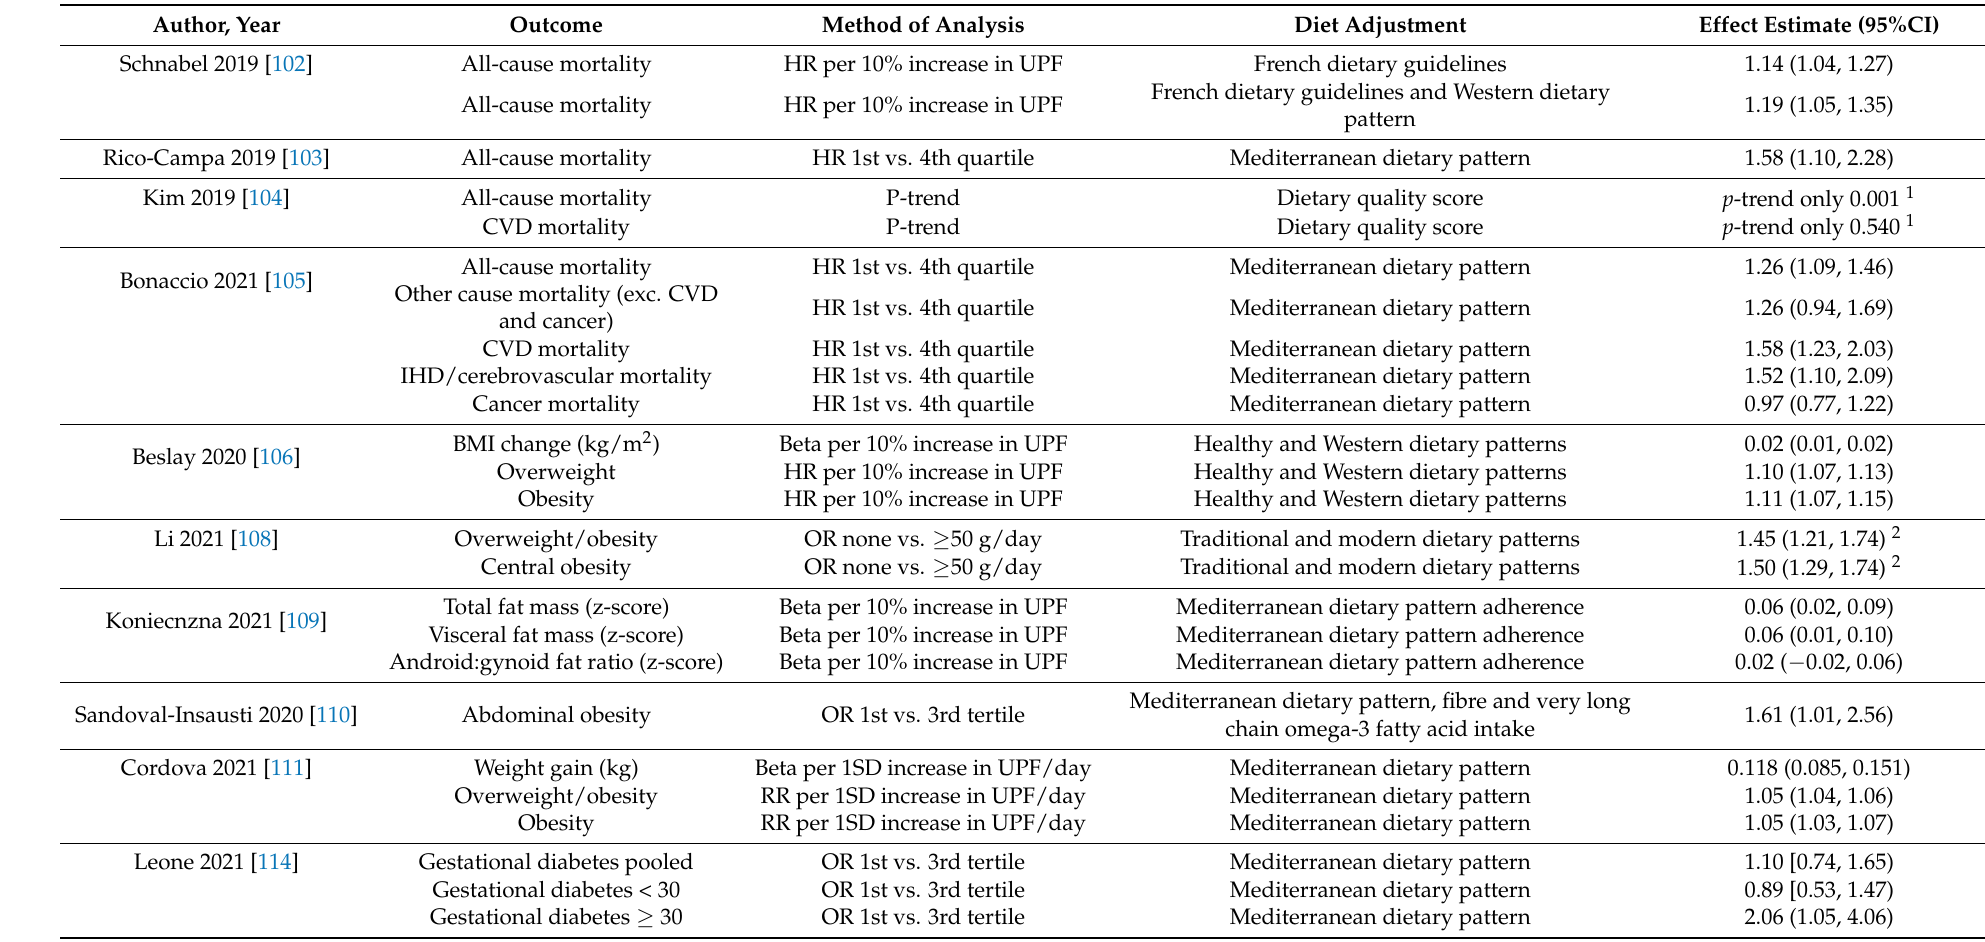
Table 4. Prospective studies adjusting for dietary